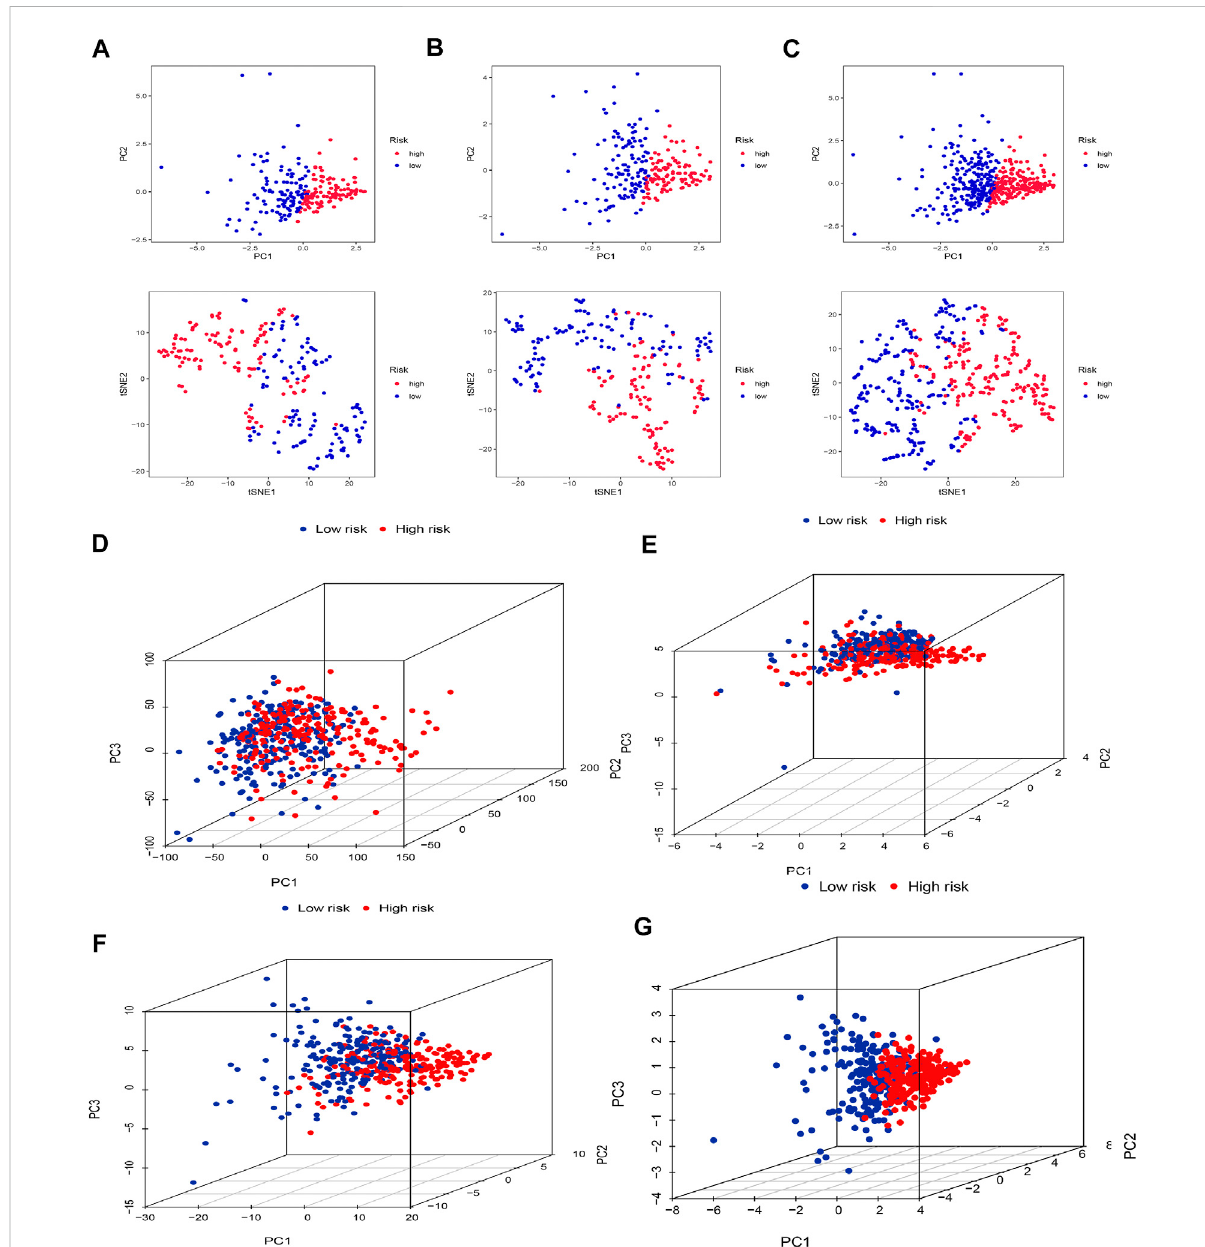
related lncRNAs (F) , and risk model (G)